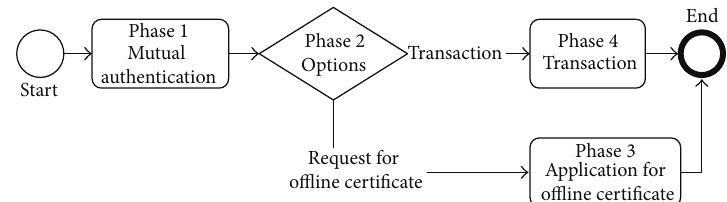
Figure 3: Flow chart of our